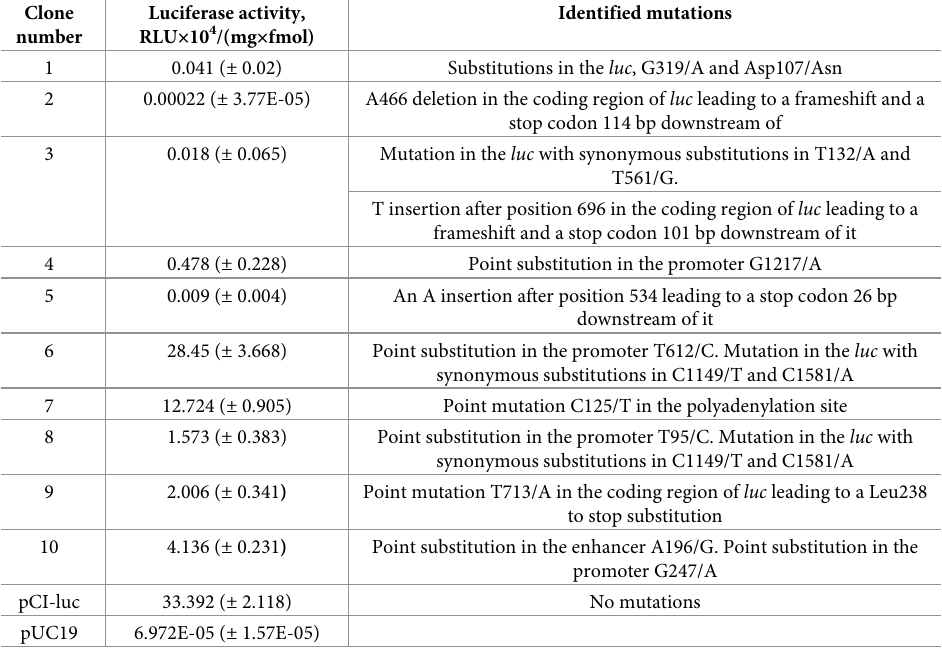
Table 1. Description of constructs obtained by cloning of individual PCR fragments into pUC19. Positions of mutant or deleted nucleotides in the promoter/operator, luciferase gene, and polyadenylation site are numbered from the beginning of the corresponding region. The standard deviation is indicated in